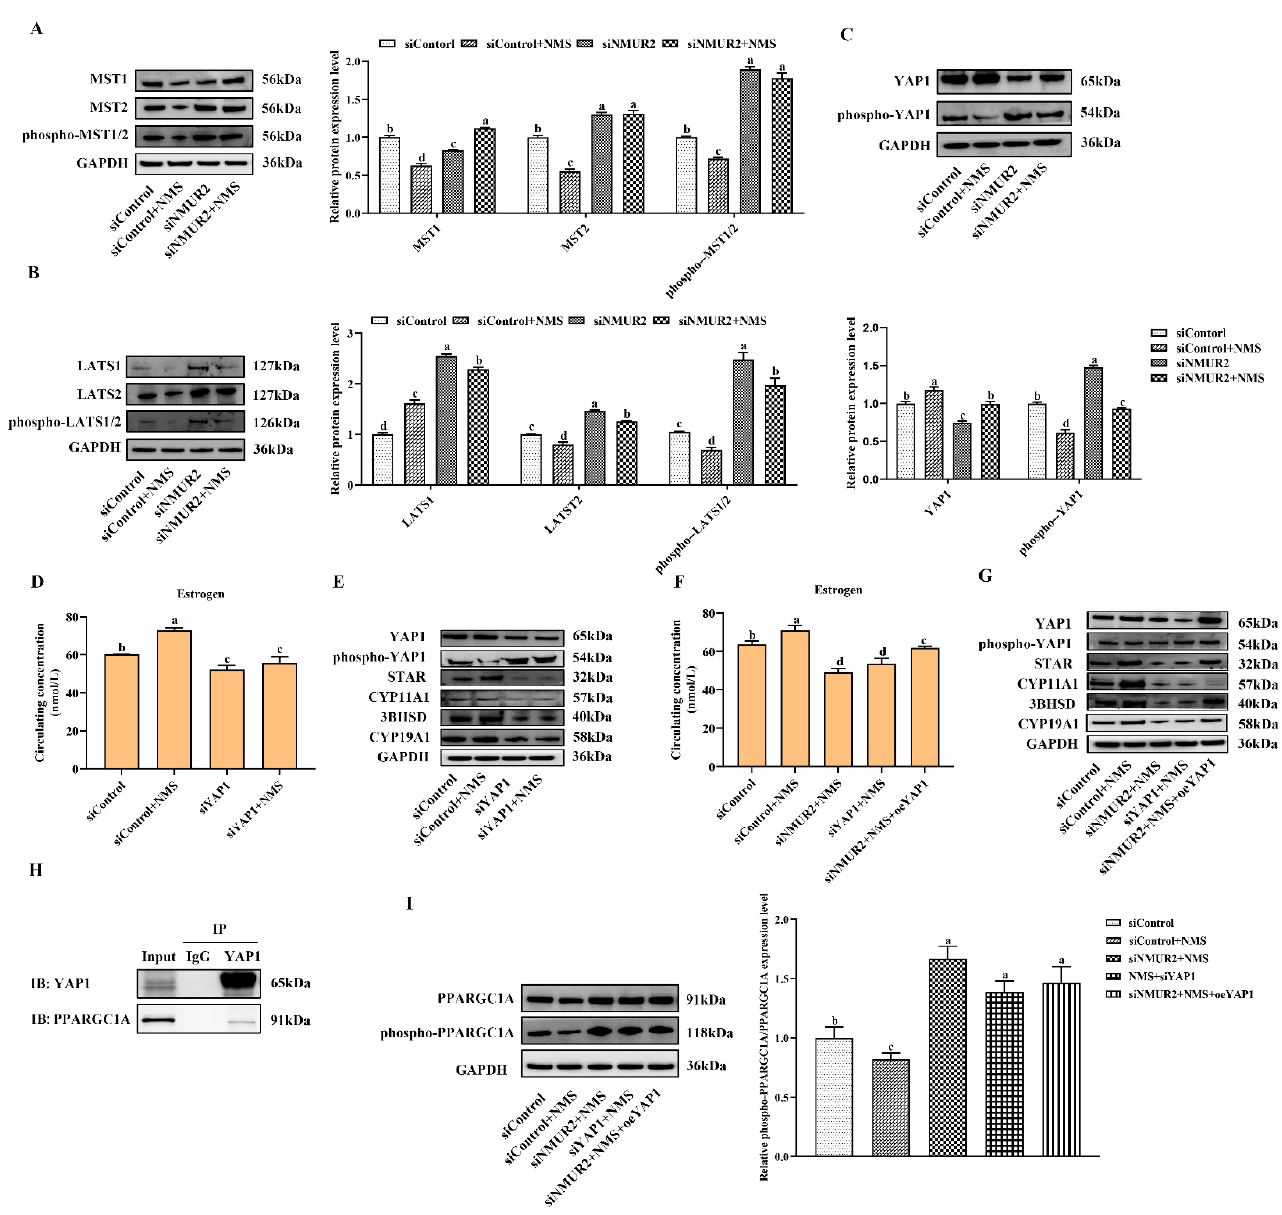
Figure 7. NMS binds to NMUR2 to promote steroidogenesis via Hippo pathway in goat granulosa cells. ( A – C ) The expression of MST1, MST2, phospho-MST1/2(Thr183), LATS1, LATS2, phospho- LATS1/2(Ser909/872), YAP1, and phospho-YAP1(Ser127) in goat GCs under NMS with or without siNMUR2 treatment were determined by qPCR. ( D ) The level of estrogen secretion under siYAP1 treatment in goat GCs. ( E ) The protein expression of STAR, CYP11A1, 3BHSD and CYP19A1 under siYAP1 treatment in goat GCs was determined by Western blot. ( F ) The level of estrogen secretion under siNMUR2 and oeYAP1 cotreatment in goat GCs. ( G ) The protein expression of STAR, CYP11A1, 3BHSD and CYP19A1 under siNMUR2 and oeYAP1 cotreatment was determined by Western blot. ( H ) Coimmunoprecipitation analysis of YAP1 protein with PPARGC1A protein. ( I ) The expression of phospho-PPARGC1A(Ser571)/PPARGC1A. Data are expressed as fold change and are presented as mean ± S.E.M. value from at least three individuals. Different letters indicate significant differences in the expressions between the groups ( p < 0.05).